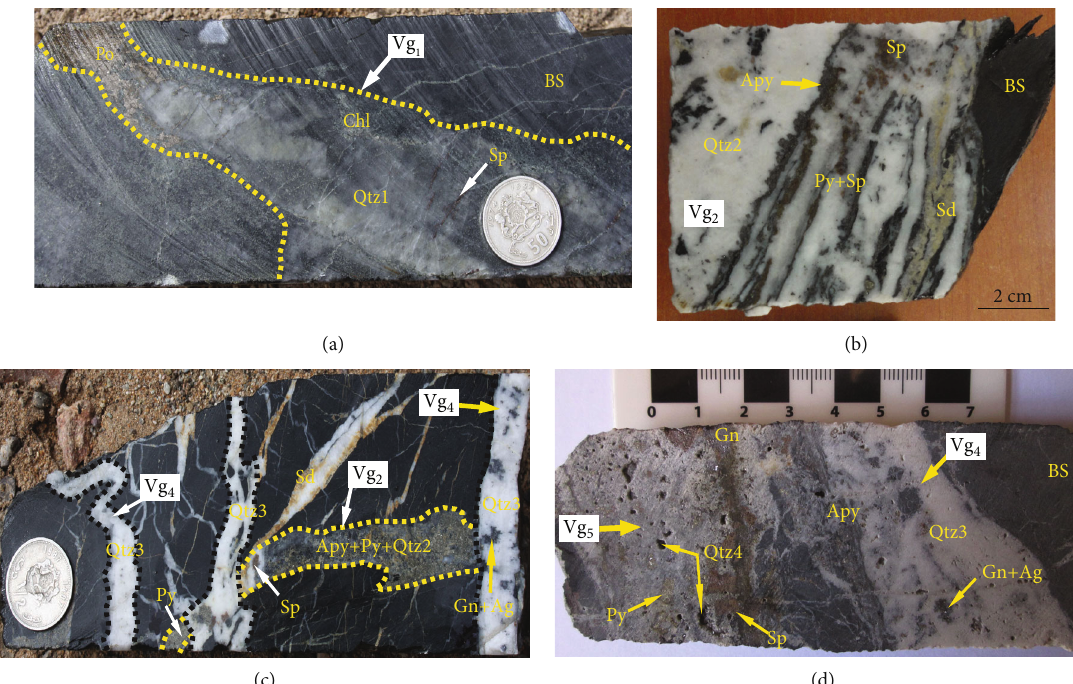
Figure 3: Photographs of representative samples from the Roc Blanc deposit, showing the structural relations between veins. (a) Vein (vg consisting of quartz (Qtz1), chlorite, and ore minerals (Po, Sp, and Ccp) cutting across the bedding ( S minerals (chlorite) are developed on vein boundaries. (b) Banded vein (vg arsenopyrite, and pyrite. (c) Quartz (Qtz3) galena and silver mineral veins (vg brown sphalerite, coarse-grained galena, pyrite, and quartz (Qtz4) of the vg coarse-grained disseminations in the galena. Wall-rock (BS: black shale) fragments in the ore are altered to sericite and